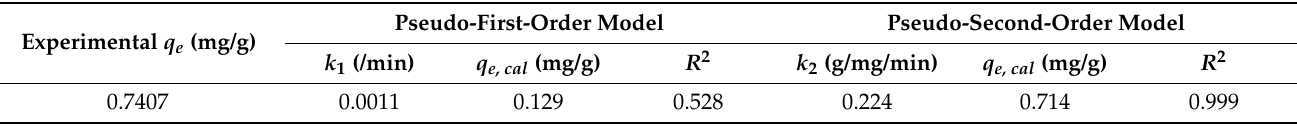
Figure 4. Effect of contact time on biosorption of Cd (biomass dosage: 5 g/L; Cd initial conc.: 4 ppm; temperature: 27 ◦ C; pH: 5.0). Table 4. Comparison between adsorption rate constants ( k ), the estimated q e and the coefficient of correlation ( R 2 ) associated with the pseudo-first-order and pseudo-second-order adsorption.